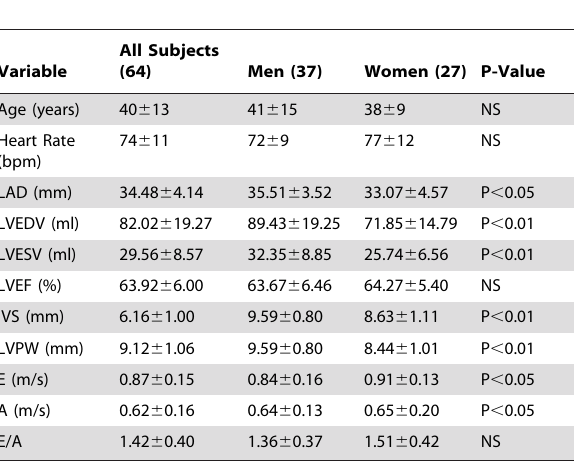
Table 1. The basic Information of conventional two- dimensional Doppler echocardiography (mean 6 SD).